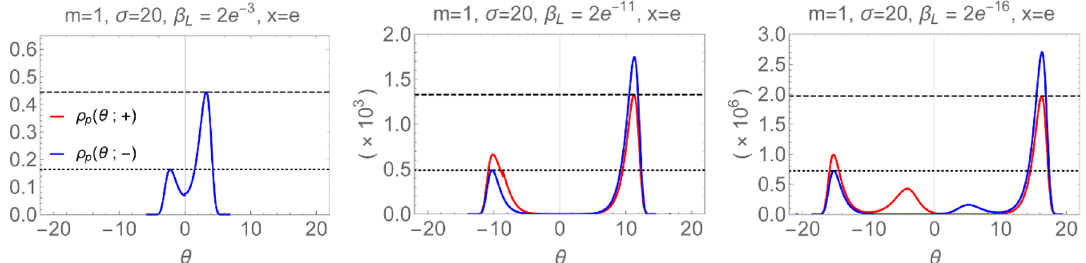
Figure 10 . Spectral Densities for x = e ( T L > T R ) and three values of the inverse temperatures ( (cid:12) L = 2 e (cid:0) 3 ; 2 e (cid:0) 11 and 2 e (cid:0) 16 ). For the two highest temperatures the vertical axis labels should be multiplied by 10 3 and 10 6 , respectively, as indicated. In all panels, dashed (dotted) horizontal lines indicate the height of the free-fermion peaks, 0 : 04431 : : : =(cid:12) L (0 : 04431 : : : =(cid:12) R ). A more complete picture of the dynamics can be gained from this video